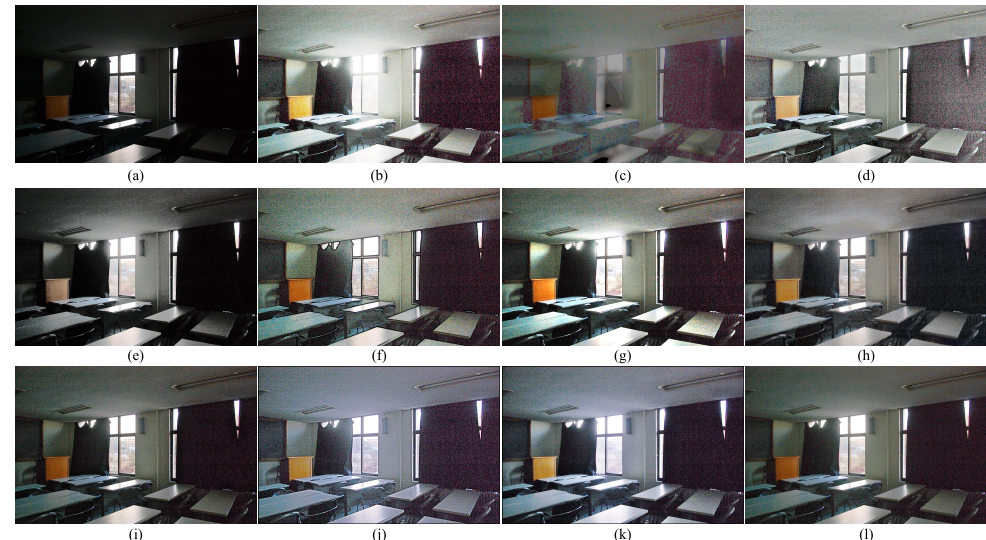
Figure 3. Visual comparison between low-light image enhancement results in the exemplar image.